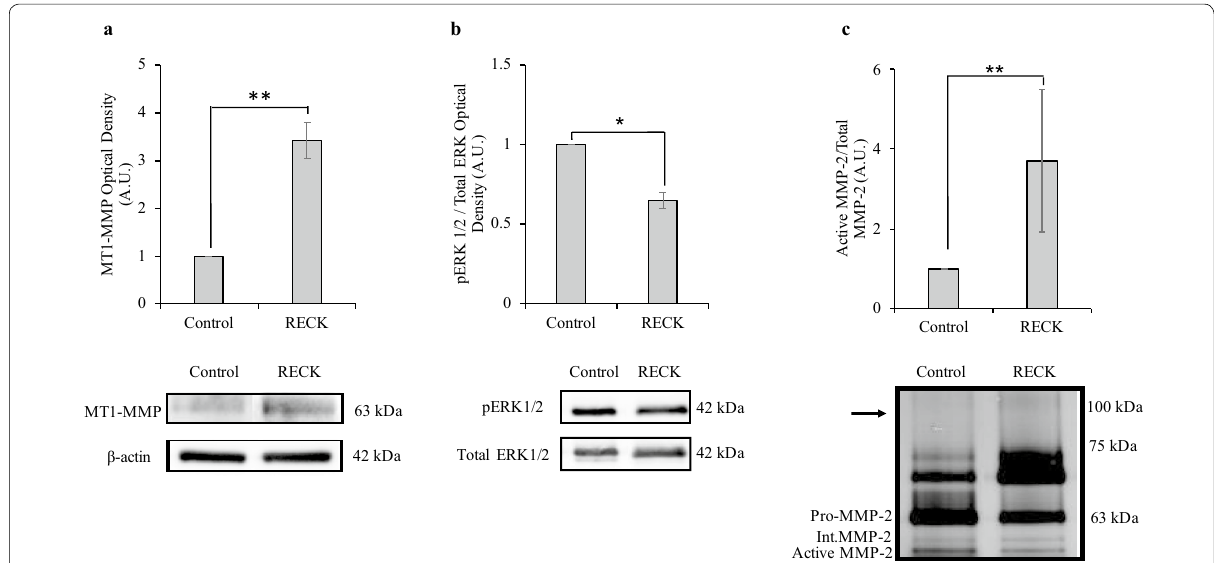
Fig. 4 RECK overexpression increased MT1-MMP protein and MMP-2 activity levels and decreased pERK protein levels. a Densitometry quantification of immunoblots of MT1-MMP protein normalized to β-actin. MT1-MMP protein levels significantly increased in RECK-overexpressing cells compared to control (set to 1). b Densitometry quantification of pERK normalized to total ERK levels. pERK protein levels significantly decreased in RECK-overexpressing cells compared to control (set to 1). c Gelatin zymography was used to measure protein levels of secreted pro-, intermediate, and active MMP-2 following RECK overexpression in A6 cells. Data is presented as the ratio between active and total (pro-, intermediate, and active) MMP-2 levels between control and RECK-overexpressing cells. Active/total MMP-2 levels significantly increased in the media of RECK-overexpressing cells compared to control (set to 1). Secreted MMP-9 protein could not be detected at the expected size of 92 kDa (shown by the arrow). Graphed data is based on 3 biological replicates (mean SD). Data is analyzed via t-test; *, p 0.05; **, p 0.01 ± ≤ ≤